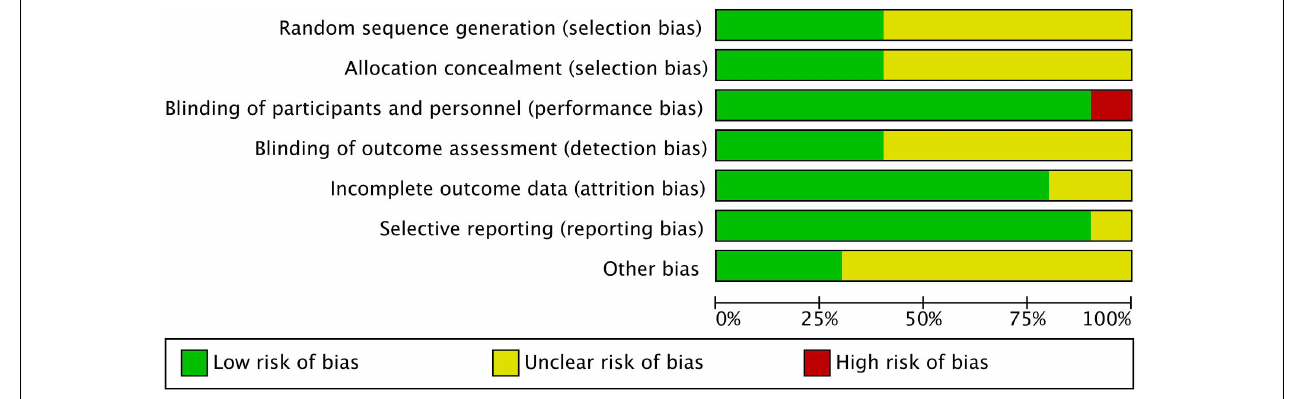
FIGURE 2 | Risk of bias